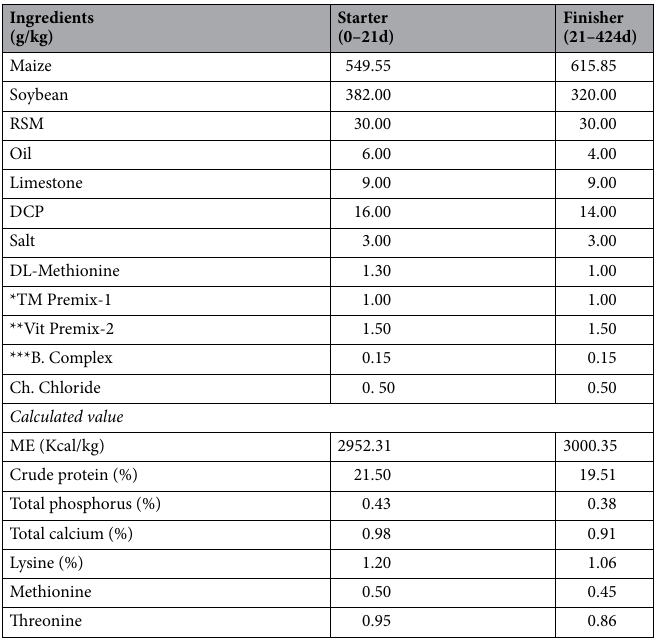
Table 7. Composition of basal diet where dietary supplementation of prebiotics were added. *Premix 1: Each g of mineral mixture contained: 200 mg of FeSO 4 ·7H 2 O, 20 mg of CuSO 4 ·5H 2 O, 200 mg of MnSO4.H2O, 150 mg of ZnSO 4 .7H 2 O, 1 mg of KI. ** Premix 2 : Each g of vitamin A, B 2 , D 3 , K (Spectromix, Ranboxy) provided: vitamin A (retinol)-540 mg, vitamin B2 (riboflavin)-50 mg, vitamin D 3 (cholecalciferol)-400 mg, vitamin K (menadione)-10 mg. ***B. Complex : Each g of B-complex provided: vitamin B1 (thiamine)-2 mg, folic acid- 10 mg, pyridoxine HCl-4 mg, cyanocobalamin-10 µg, nicotinamide-12